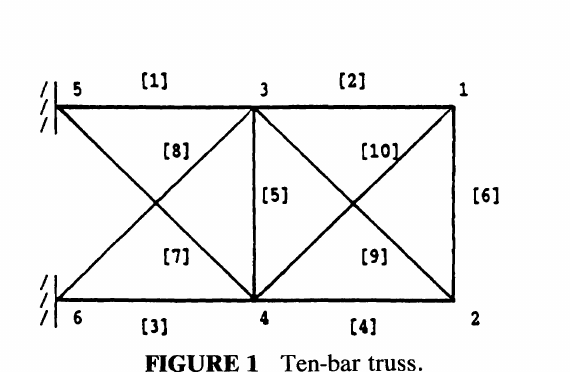
FIGURE 1 Ten-bar